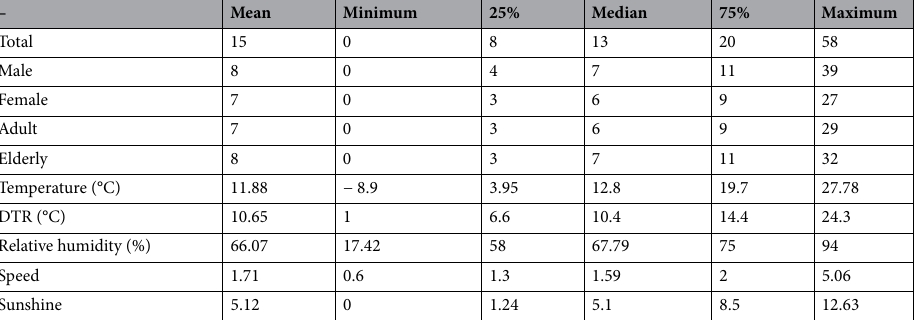
Table 1. Descriptive statistics of daily CVD hospital admissions and weather variables in Tianshui city, China from January 1, 2018, to December 31, 2020. Minimum, 25%, median, 75% and maximum represented the